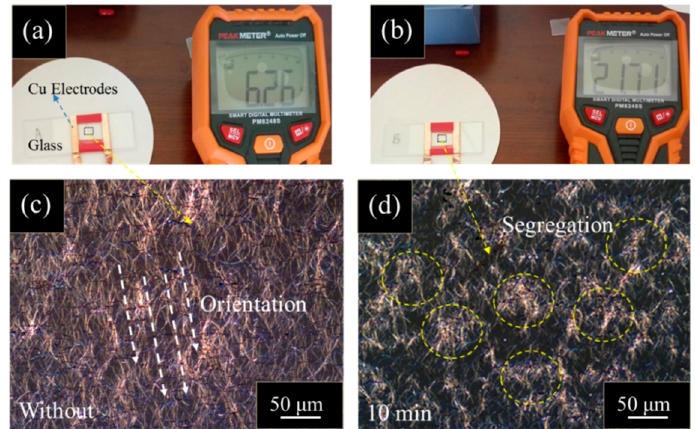
Figure 3. ( a , b ) Resistivity test of Ag nanowire films without and with 10 min ultrasonic treatment on glass substrates, respectively; ( c , d ) optic images of the Ag nanowire films without and with 10 min ultrasonic treatment, respectively. The agglomerations of Ag nanowires are marked by yellow dashed circles.